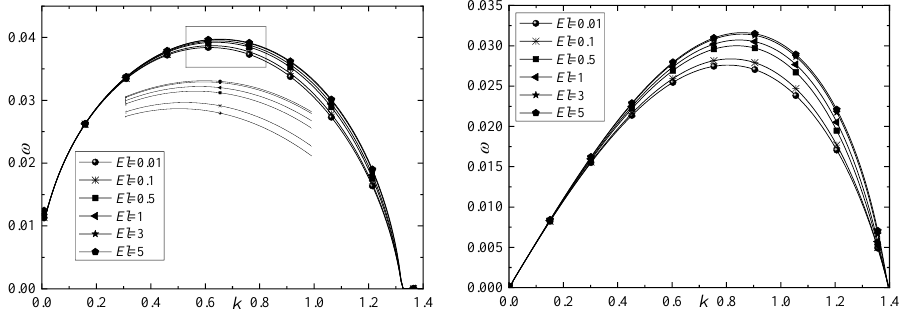
Figure 7. Effects of E l on sheet instability for sinuous and varicose modes.